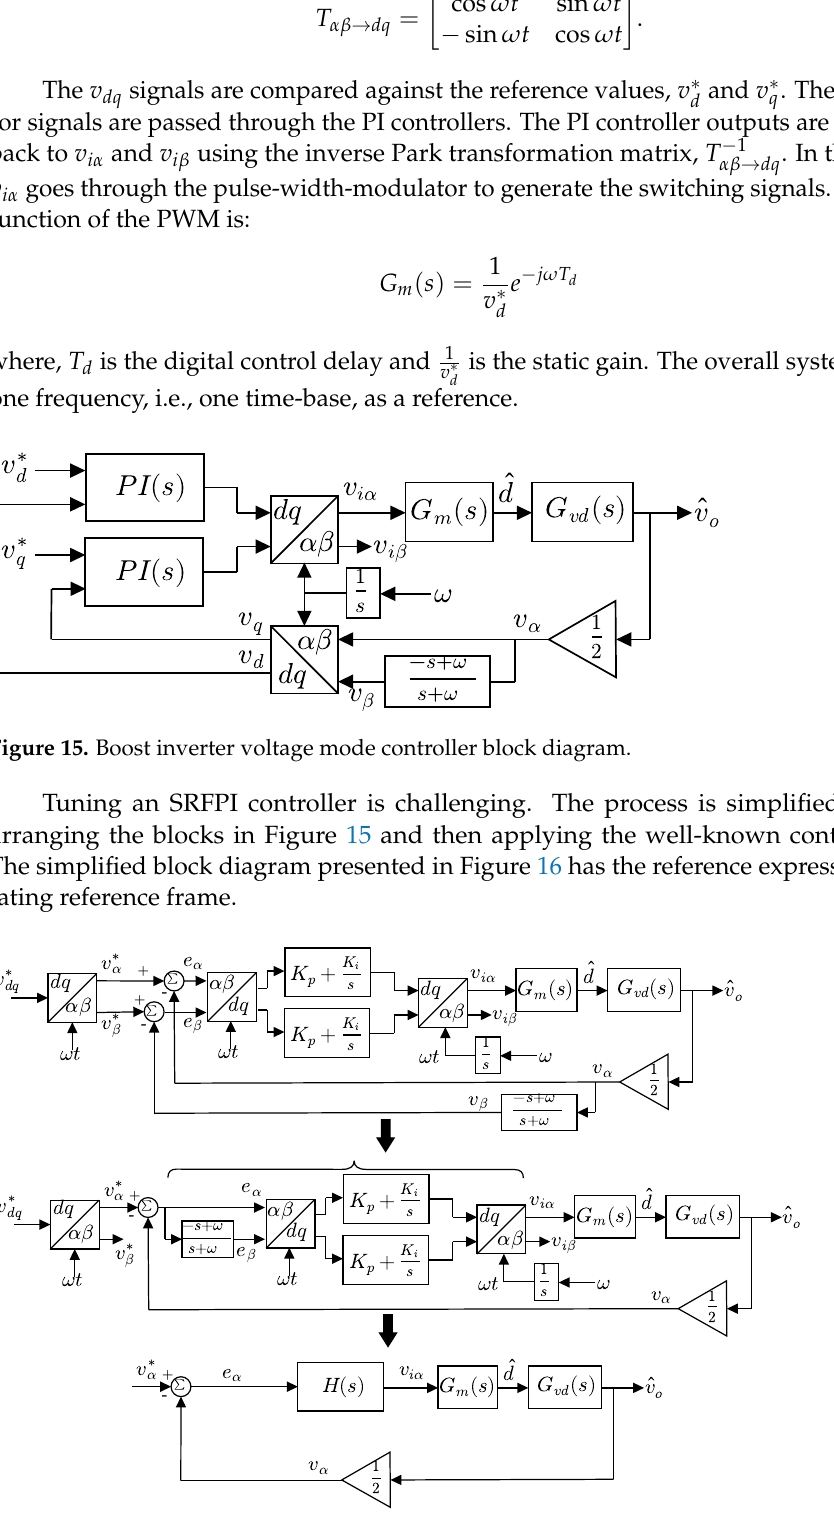
Figure 16. Controller block diagram is rearranged and